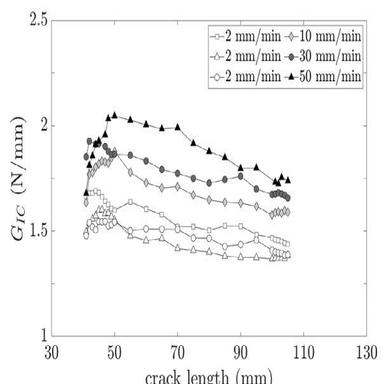
R-curves from flexible bonded joints at different displacement rates with the DCB.